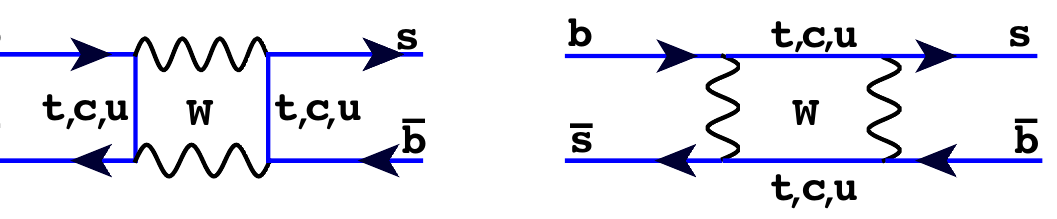
is generated 12